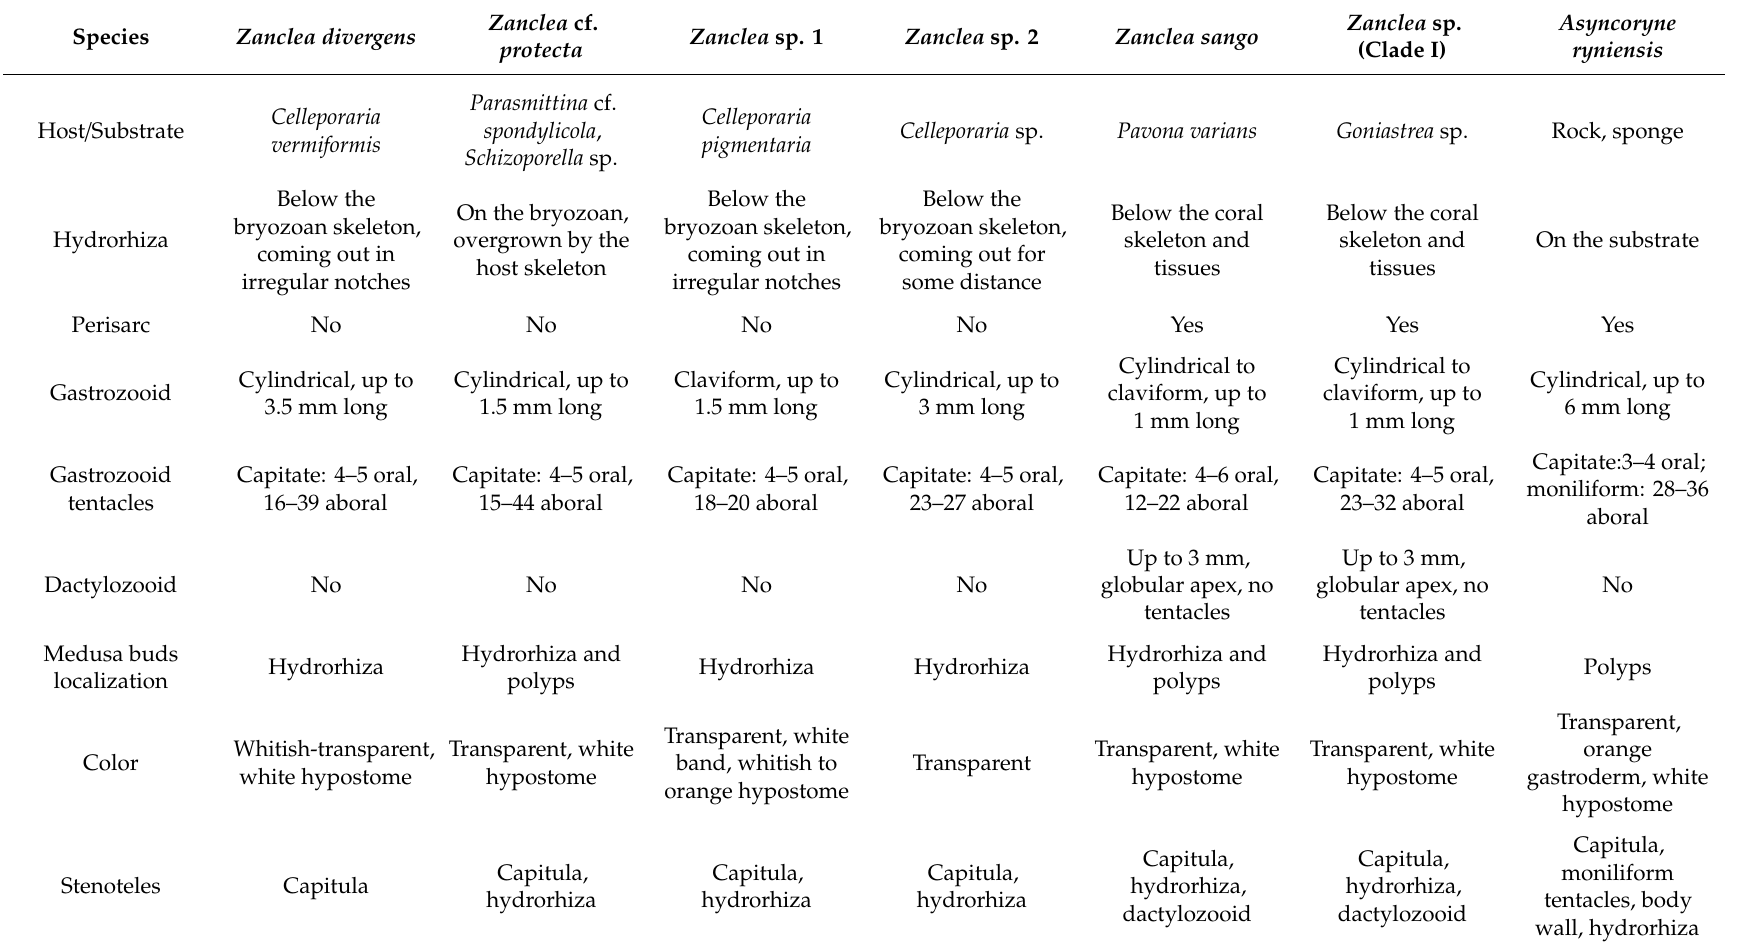
Table 1. Morphology of the polyp